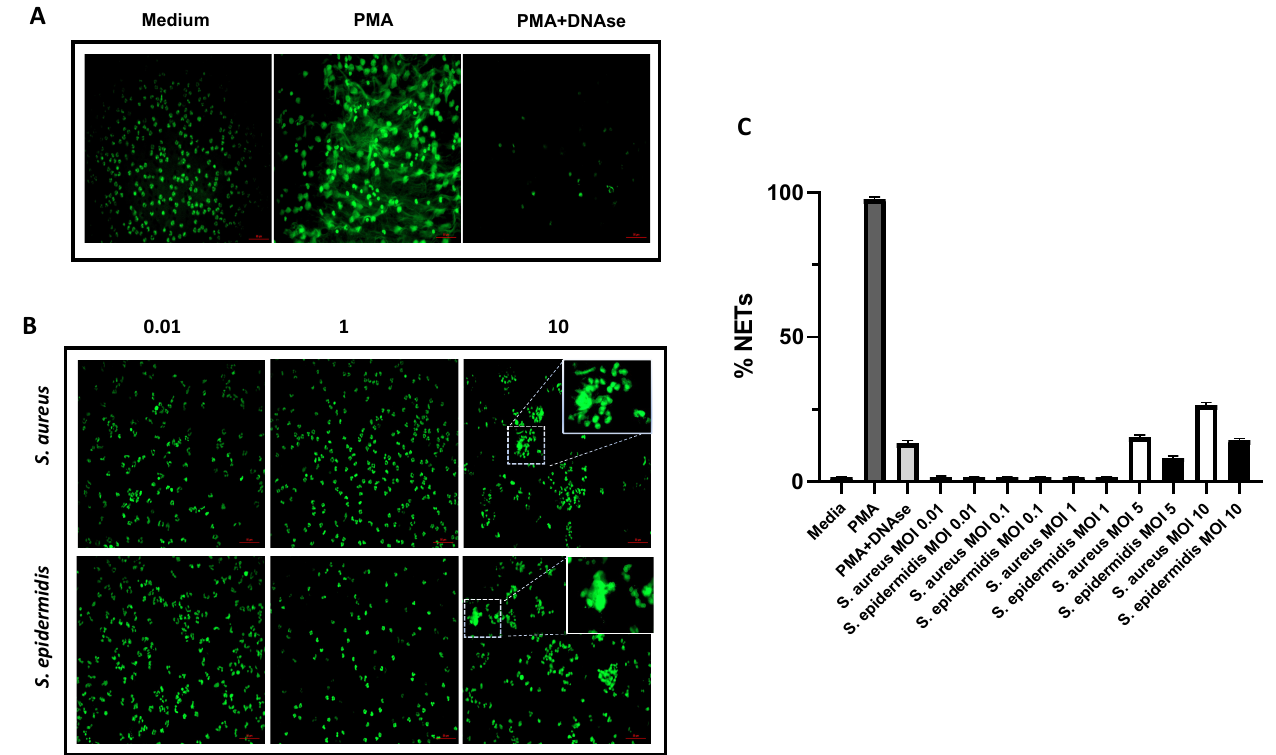
Figure 8. NETs formation. ( A ) Control conditions for NETs formation: neutrophils grown in media without bacteria (media); neutrophils treated with phorbol 12-myristate 13-acetate (PMA) for induc- tion of NETs; neutrophils treated with PMA and DNAse (PMA + DNAse 100 U). ( B ) Induction of NETs in neutrophils (0.25 × 10 6 cells /mL) grown in the presence of different MOI